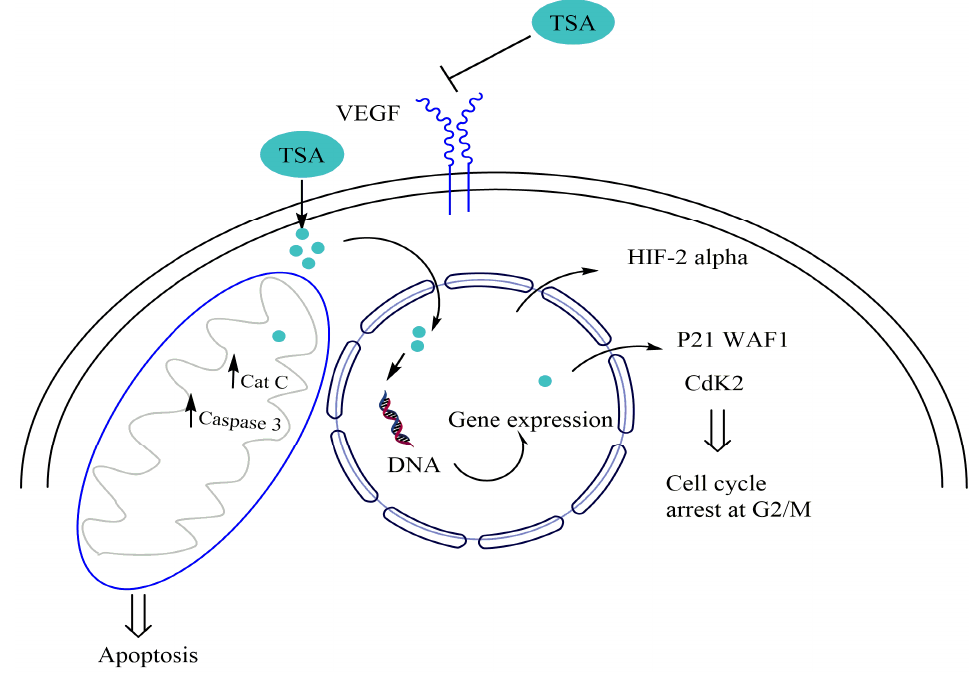
Figure 5. Mechanisms of TSA against brain cancer cells. Abbreviations: CDK: Cyclin Dependent Kinase; HIF Hypoxia Inducible Factor; VEGF: Vascular endothelial growth factor; WAF1: Wild-type P53-activated Fragment